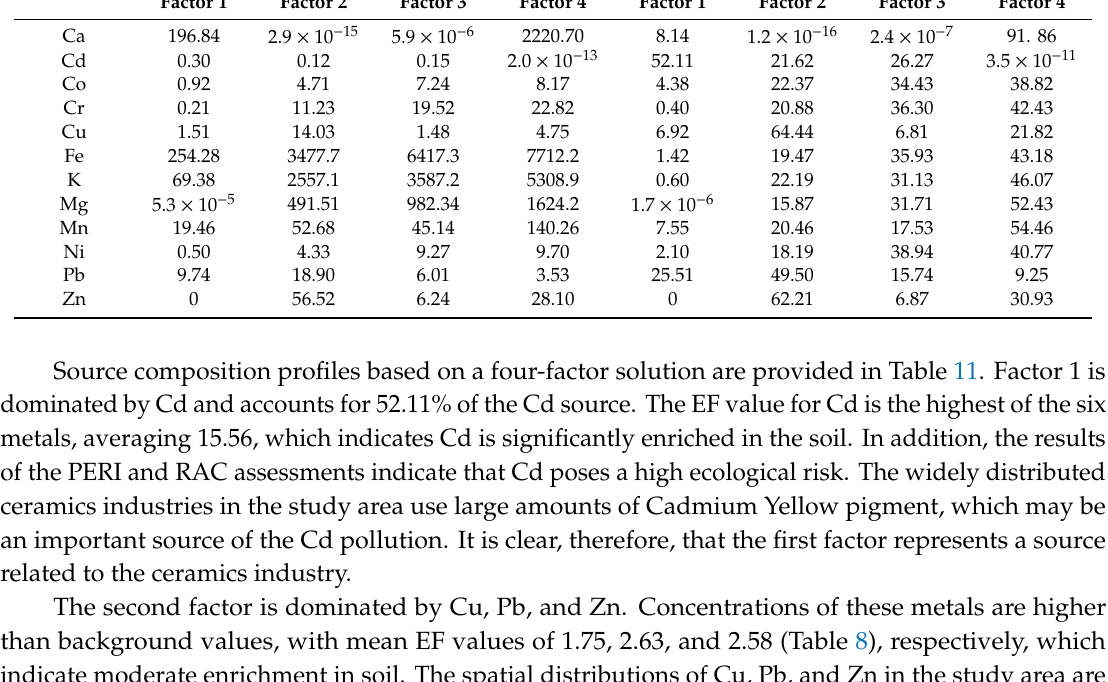
Table 11. Source contribution for di ff erent elements by positive matrix factorization (PMF).